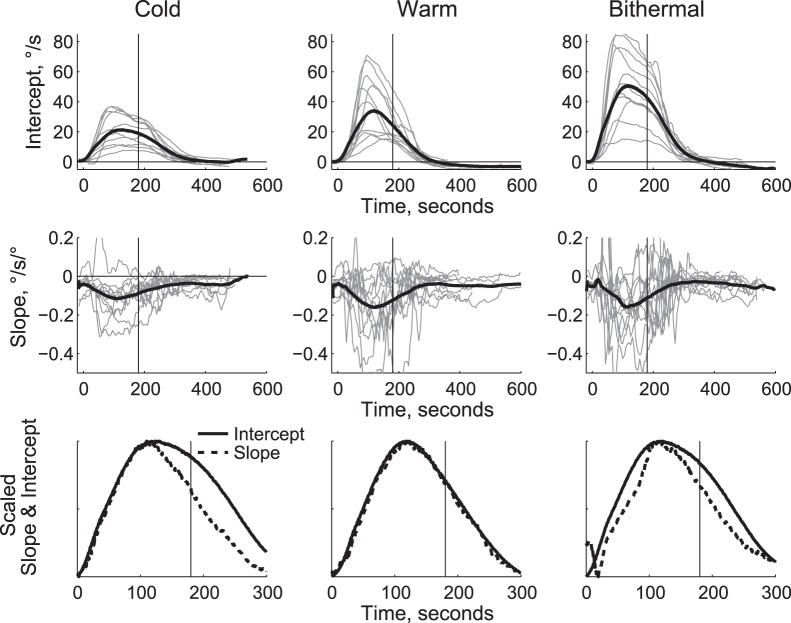
‘Sliding’ fits to all data.We made linear fits to the velocity versus position data, using 30 seconds of data, and shifting the center time every 5 seconds. The fitted intercepts (top row) and slopes (middle row) for velocity versus position are shown for each stimulation condition. The thin grey lines are individual subject data, and the thick black line is the mean. Vertical lines mark the time when caloric irrigation was stopped. In the bottom row we scaled the mean intercept and slope curves to facilitate comparison of the curves.